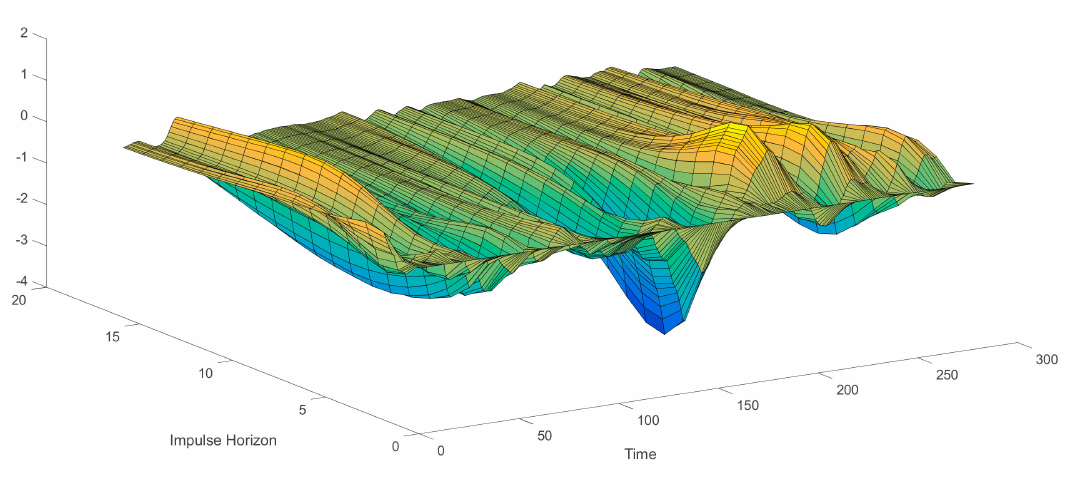
Figure 7. Impulse response function of the economic policy uncertainty due to a change in the level of the oil price for 16 months and in each moment in time from 1996M3 up until 2019M4 (Time